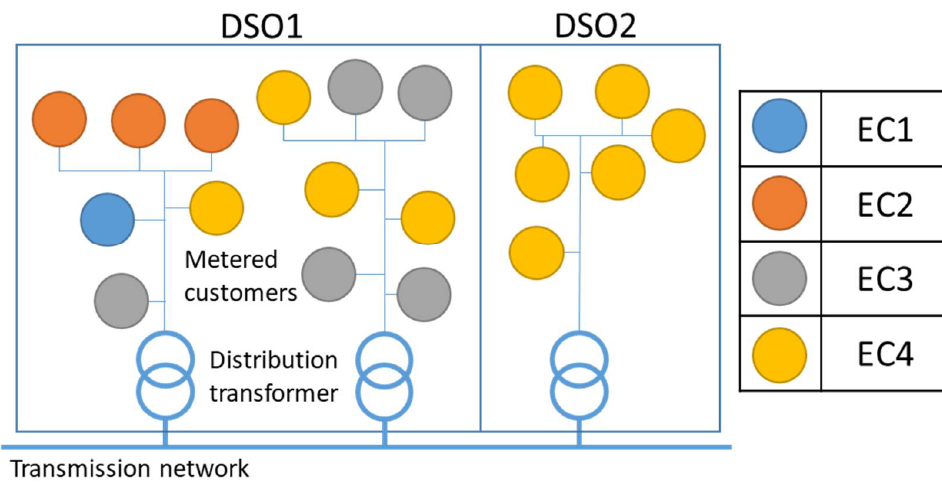
Figure 2. Schematic of pertinent energy community configurations.